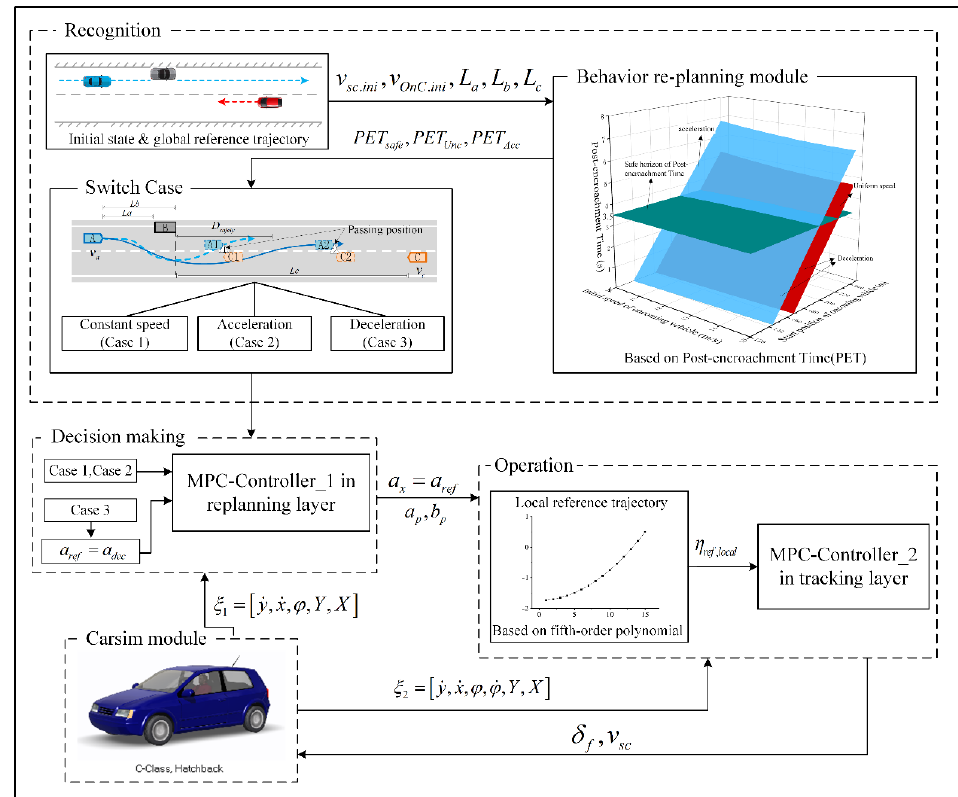
Figure 4. Control flow of proposed collision avoidance (CA) system.